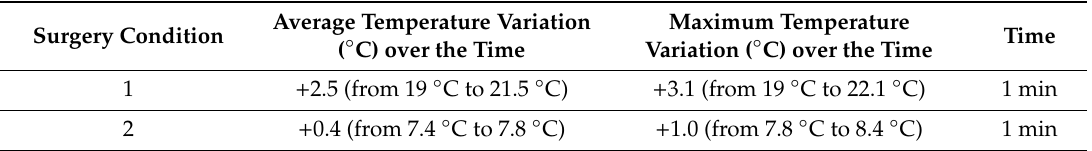
Table 4. The average and the maximum temperature variation for one minute of simulated intervention under conditions 1 and